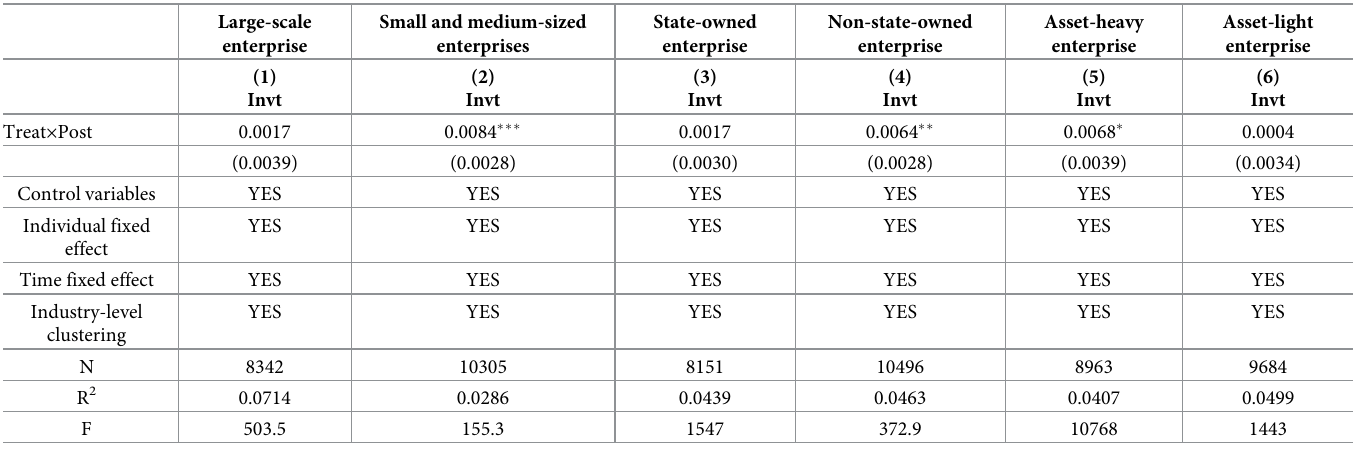
Table 8. Results of heterogeneity